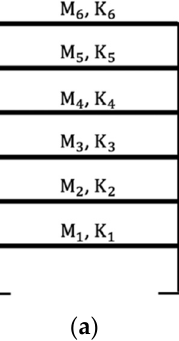
Figure 2. Six-story shear building: ( a ) original system; ( b ) modified system with curved dampers.